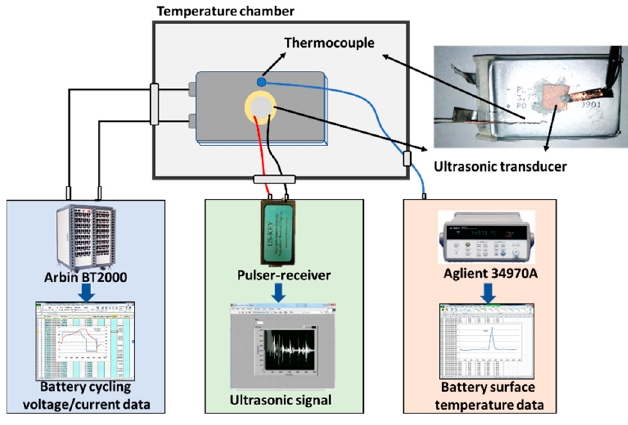
Figure 2. Battery test bench.